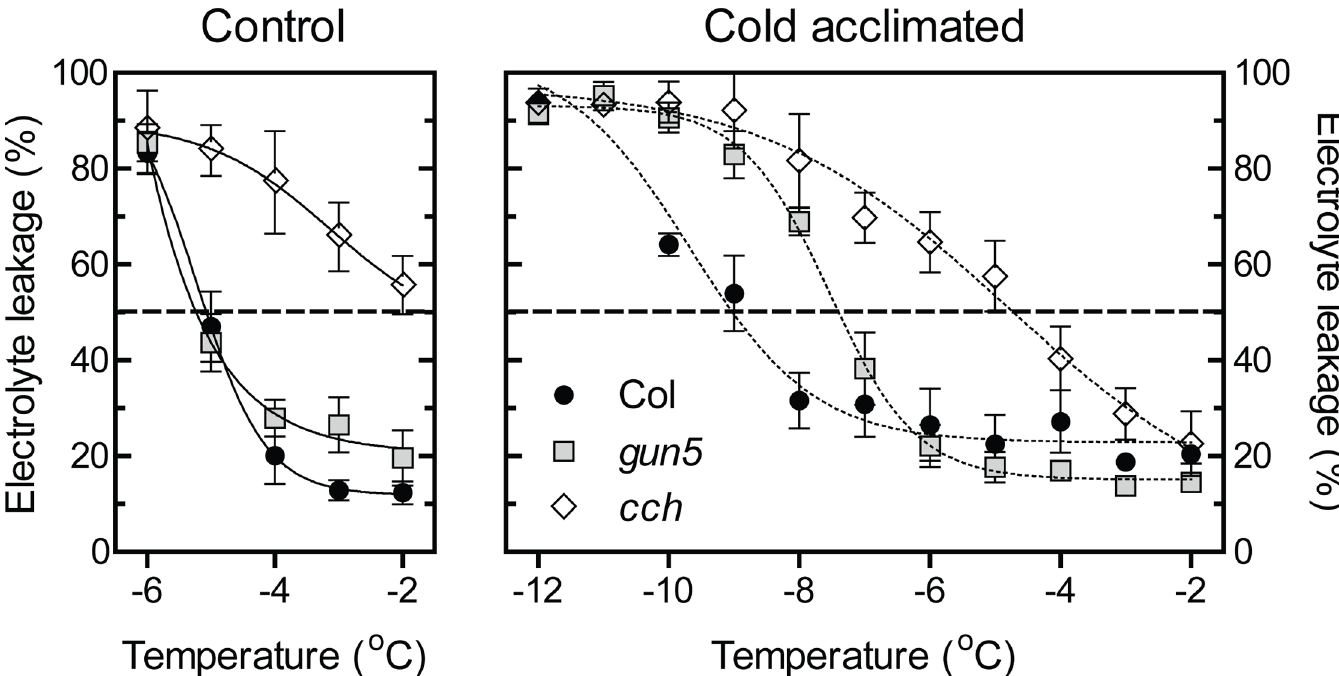
Fig 5. Freezing test of acclimated and non-acclimated Col-0, gun5 and cch plants. Plants were grown for 5 weeks in SD conditions (left panel, non- acclimated) and transferred to SD conditions, 4°C for 3 days (right panel, cold-acclimated). Leaf discs of respective plant were exposed to decreasing temperatures (2°C/h) and checked for electrolyte leakage. Each data point represents values from at least three biological replicates ( ± SD).